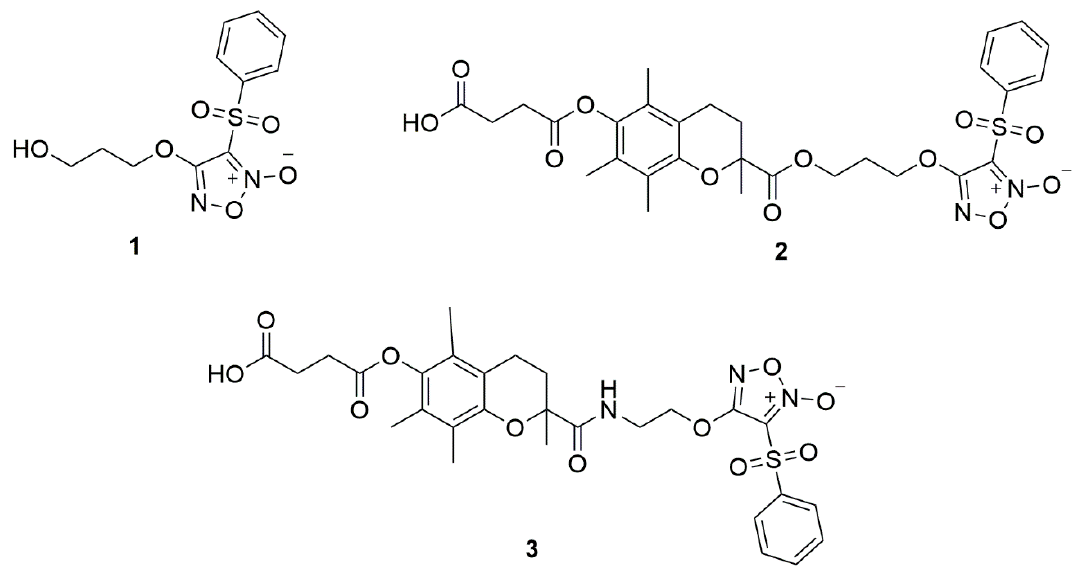
Figure 1. Structures of compounds 1 , 2, and 3 .